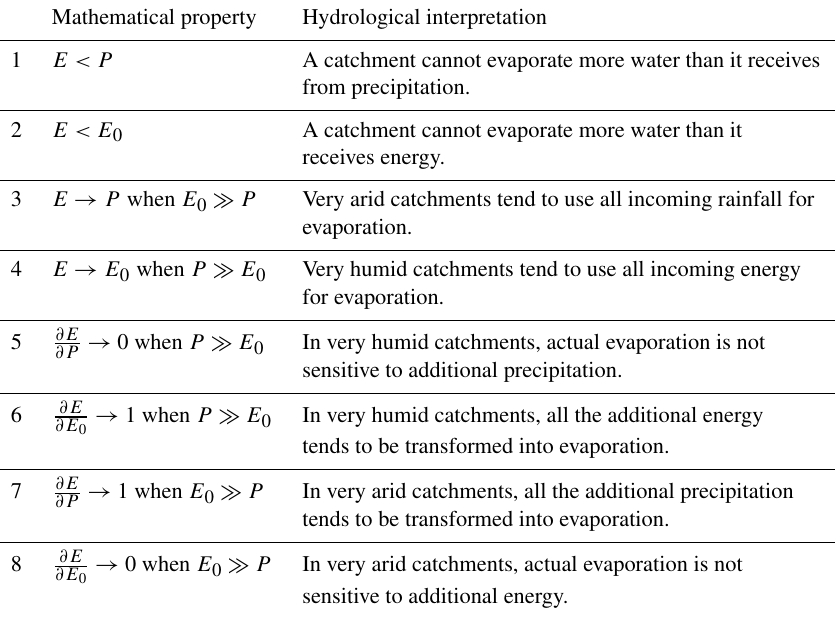
Table 5. Hydrological interpretation of the Turc–Mezentsev and Tixeront–Fu formulas, applied to actual evaporation ( P – precipitation, E 0 – maximum evaporation, E – actual evaporation, all in mmyr − 1 averaged over many